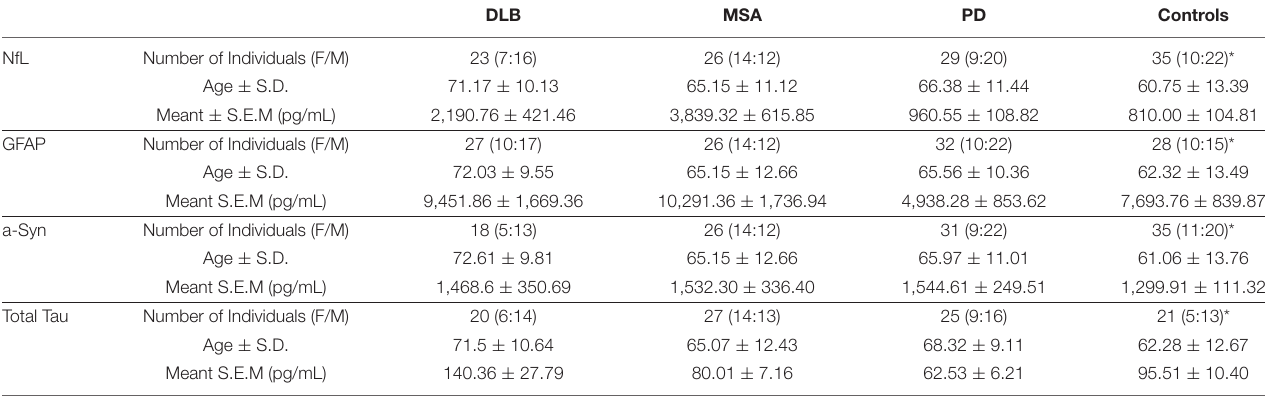
TABLE 1 | Summary of the demographic information about patients and biomarker concentration. DLB MSA PD